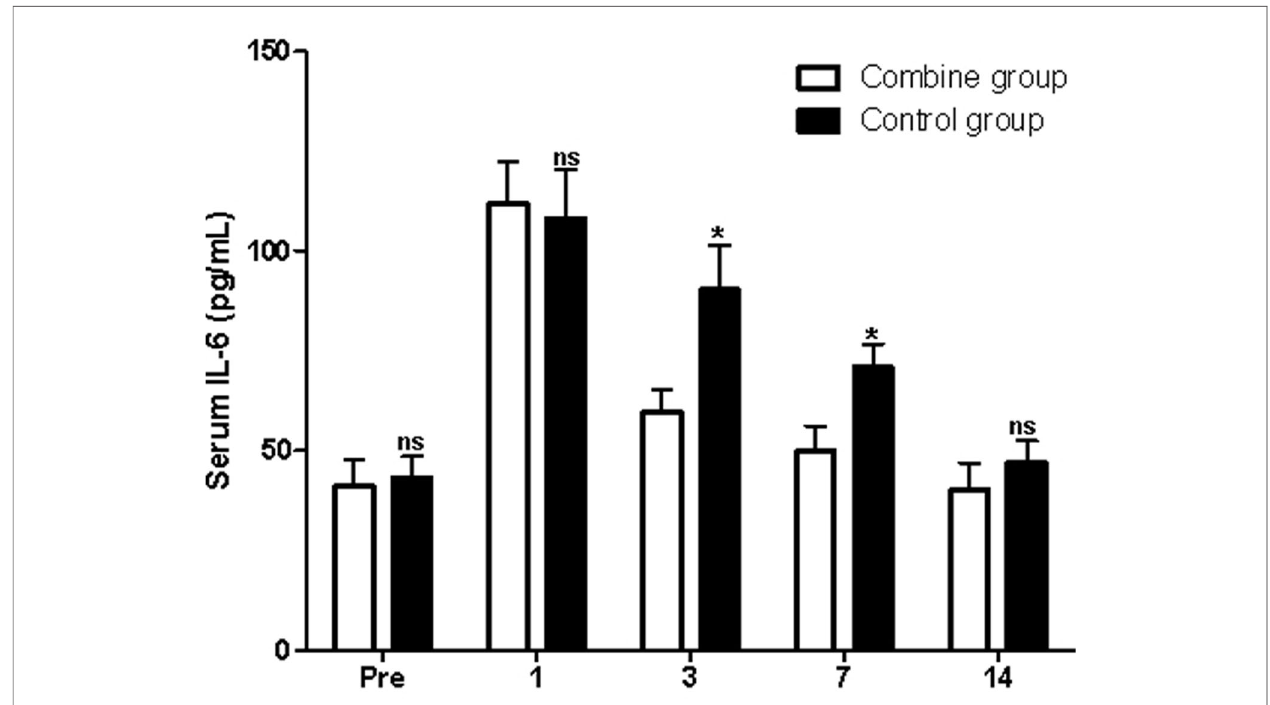
FIGURE 6 | Comparison of serum IL-6 levels at different times in patients of two groups. Note: Compared with the combine group, ns p >0.05 and * p <0.05.